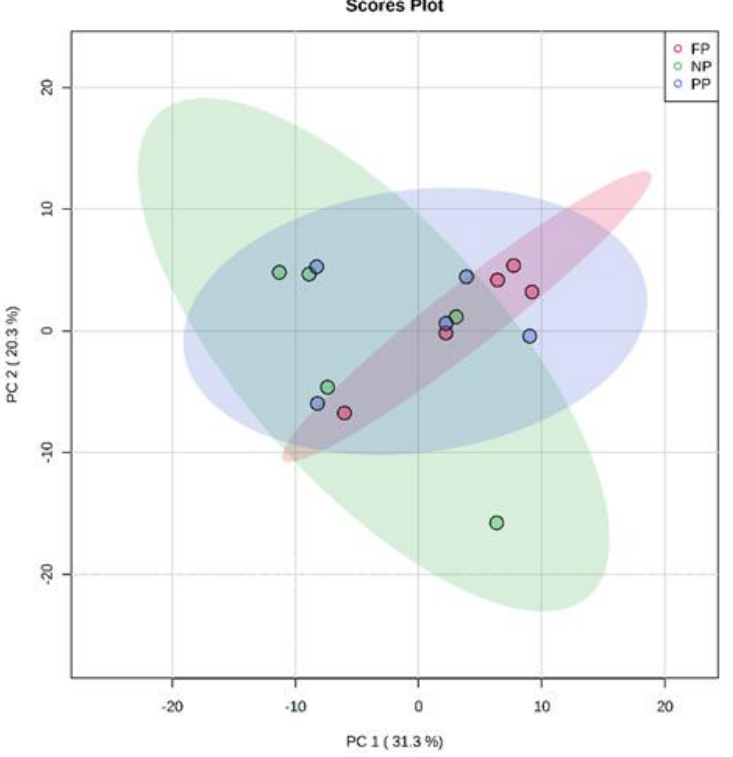
Figure 2. Principal component analysis (PCA) scores plot of metabolome distribution of bulls’ blood plasma in the finishing phase among the treatments (NP, PP and FP).